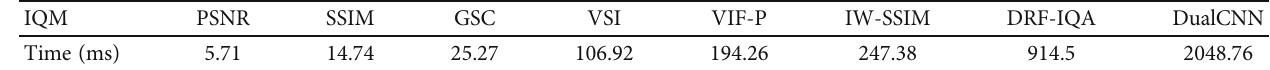
Table 5: Run time comparison of IQMs in terms of